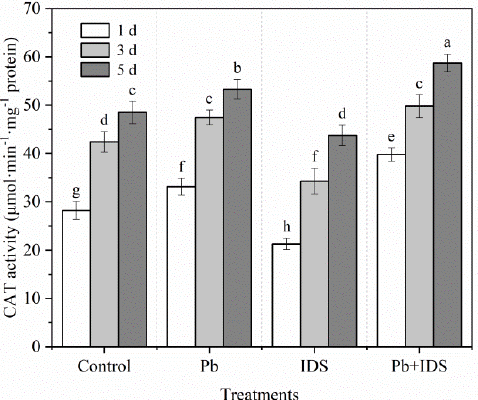
Figure 10. Effects of Pb, IDS, and Pb+IDS on CAT activities of maize seeds. Maize seeds treated with distilled water (control), Pb (20 mmol · dm − 3 PbCl 2 ), IDS (100 mmol · dm − 3 ), or Pb+IDS were used, and their CAT activities were measured 1, 3, and 5 d after sowing. Error bars represent the standard deviation of the mean ( n = 5). Means associated with different letters are significantly different among treatments and time points ( p < 0.05; Duncan’s new multiple range test). Pb, lead; IDS, iminodisuccinic acid; CAT,